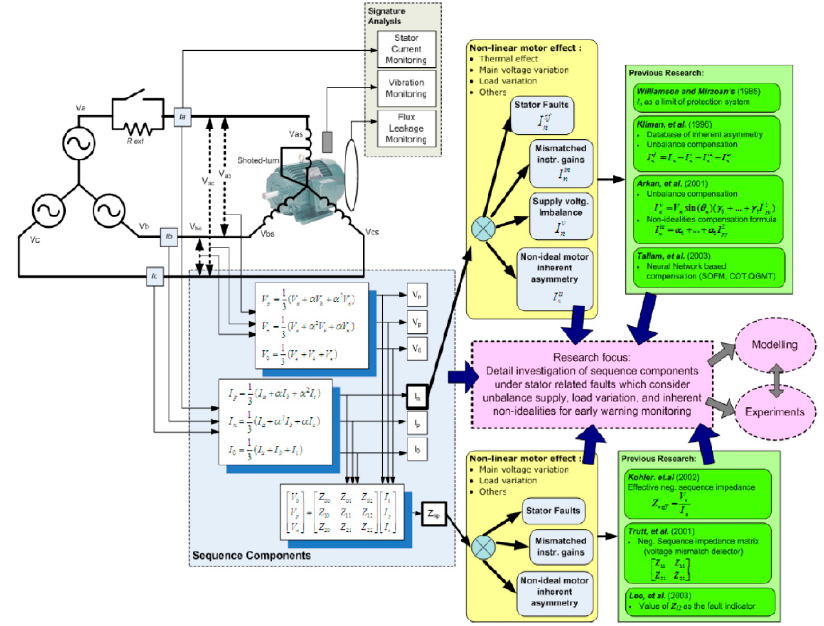
Figure 2. The summary of previous studies and the research opportunities for negative sequence components.